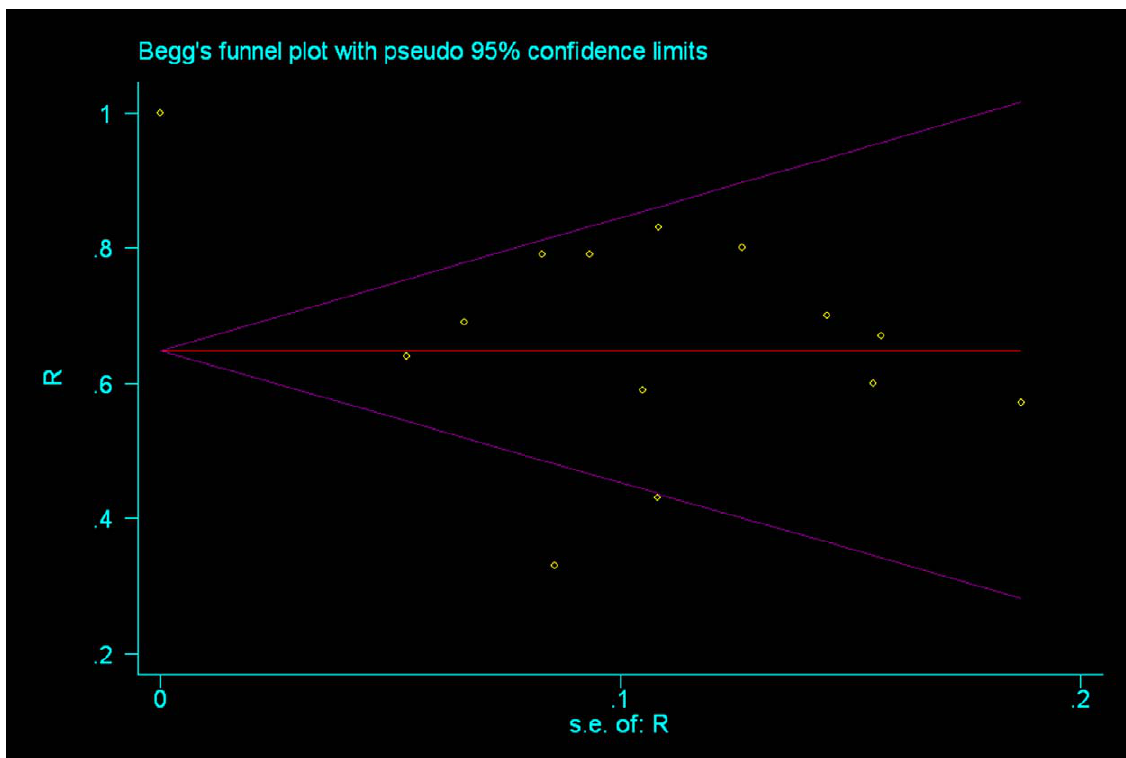
Figure 4. Begg funnel plot with pseudo 95% for studies reporting response. This plot is created by STATA 11.1. For each study, the response rate is plotted against its standard error. The funnel plot suggests no significant asymmetry, indicating no evidence of substantial publication bias.